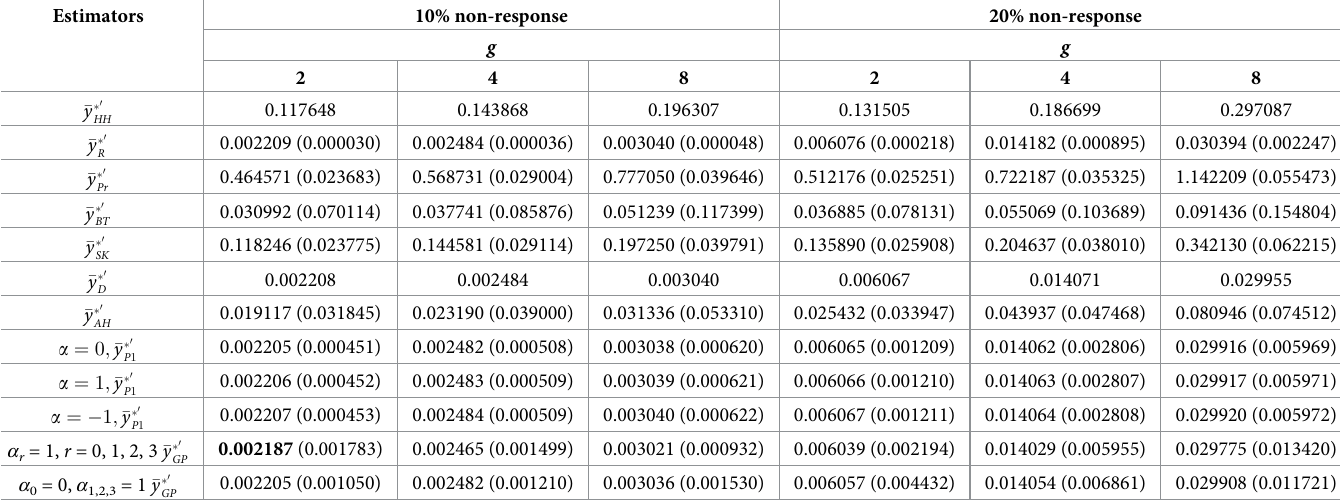
Table 5. Mean squared error and | Bias | (in brackets) values for different estimators for Population II without measurement error. Estimators